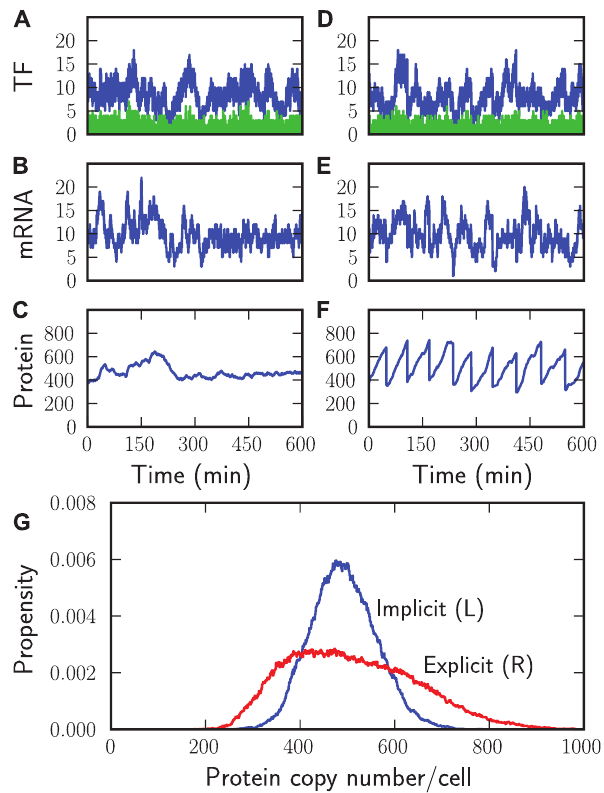
Figure 7. Modeling single-cell transcription and translation with and without cell division. StochPy plots of simulating stochastic gene expression. Modeling details of cell division periods: Gamma-distributed with scale parameter is 60.0 and shape parameter is 1.0. Implicit and explicit time series of transcription factor copy numbers (A and D), mRNA copy numbers (B and E), and protein copy numbers (C and F). Distributions of protein copy numbers for modeling cell division explicitly and implicitly (G). The model is further described in Information S1 Section 5.